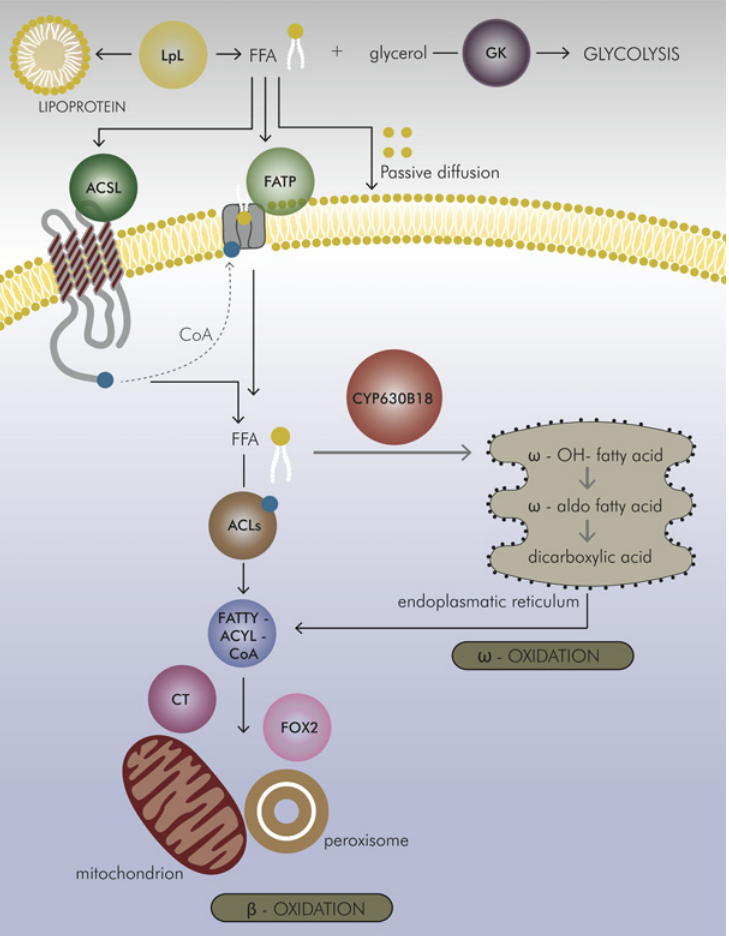
Fig 5. Proposed model for the role of Gs CYP630B18 in fatty acid oxidation. The putative involvement of Gs CYP630B18 is indicated by grey arrows. Triglycerides from the host plant in the lipoprotein are broken down to free fatty acids (FFA) and glycerol by the action of the lipoprotein lipase (LpL) [57]. Glycerol is further phosphorylated by glycerol kinase (GK) [58, 59] and enters glycolysis. On the cytosolic site, FFAs are activated and coupled to coenzyme A (CoA) by the catalysis of long-chain fatty acyl-CoA synthetases (ACSLs) [60] or by different fatty acid transporter proteins (FATPs) [61]. The transfer through the plasma membrane occurs by a protein-mediated mechanism. In the cell, FFAs can act at different sub-cellular localizations and have functions in energy generation and storage, membrane synthesis, protein modification, and activation of nuclear transcription factors [62]. Oxidation of FFA in fungi occurs mainly through β -oxidation in the mitochondrial matrix or peroxisomes, or through the ω -oxidation pathway in the endoplasmic reticulum. Several acyl-CoA ligases (ACLs) [63], involved in fatty acid metabolism, then attach CoA to the ends of fatty acids to form fatty-acyl-CoA. Fatty-acyl-CoA can pass through the outer mitochondrial membrane, but requires carnitine acetyl transferase (CT) [64] to cross the inner membrane. The multifunctional β -oxidation enzyme FOX2[65, 66] was induced in Gs mycelia grown on fatty acids, indicating possible peroxisomal oxidation. In ω -oxidation, the hydroxylase reaction is catalyzed by CYP630 (red bubble) and its redox partner CPR 2. Dicarboxylic acids are then subject to further β -oxidation. Gene IDs and respective changes in transcript abundance in Gs grown on fatty acids are given in Table 3 [14,